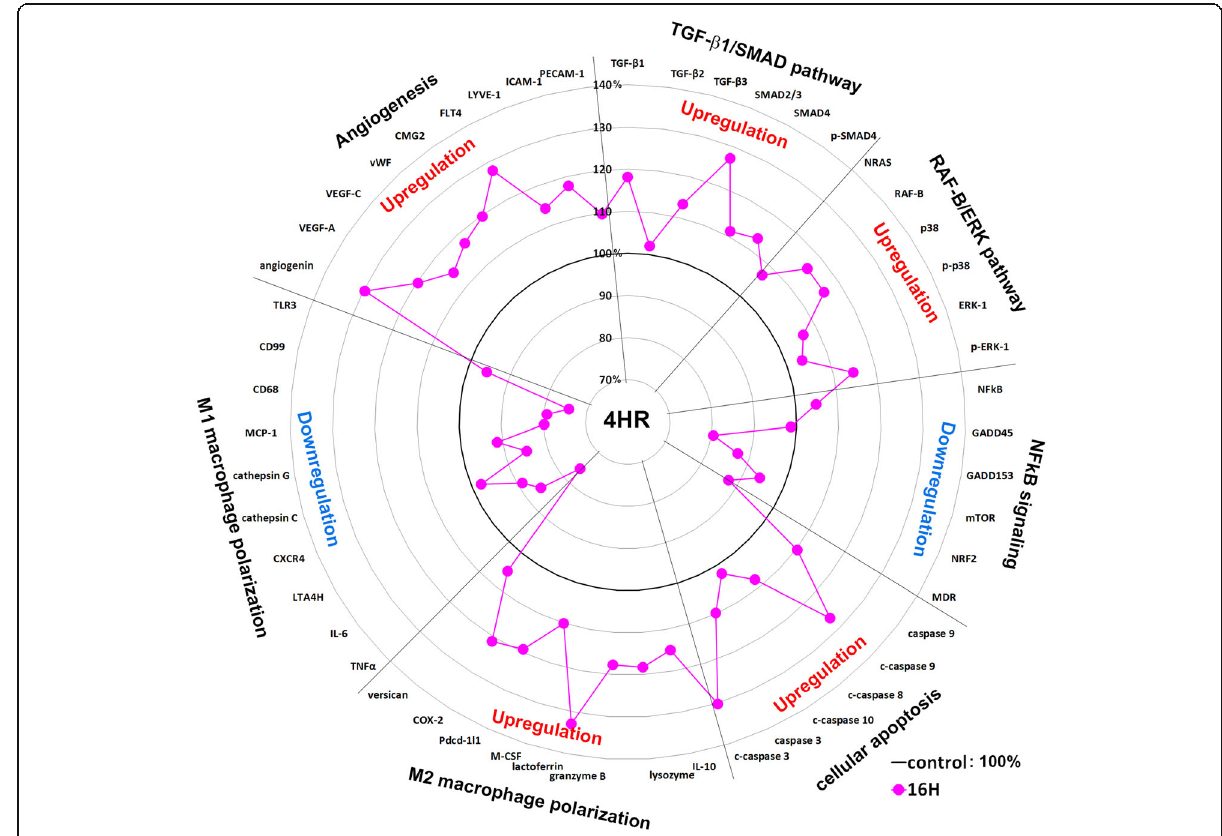
Fig. 4 Star plot of global protein expression in HUVECs treated with 4HR for 16 h. The expression levels (%) of representative proteins ( n = 51) selected from 6 major molecular signaling pathways are plotted in a circular manner. The expressions of growth factor-related proteins (TGF- β / SMAD signaling), RAS signaling proteins (RAF-B/ERK and p38 signaling), cellular apoptosis-related proteins (apoptosis executor proteins; caspase-3, caspase-8, caspase-9, caspase-10), M2 macrophage polarization proteins, and angiogenesis-related proteins were upregulated, while the expressions of NFkB signaling proteins and M1 macrophage polarization proteins were